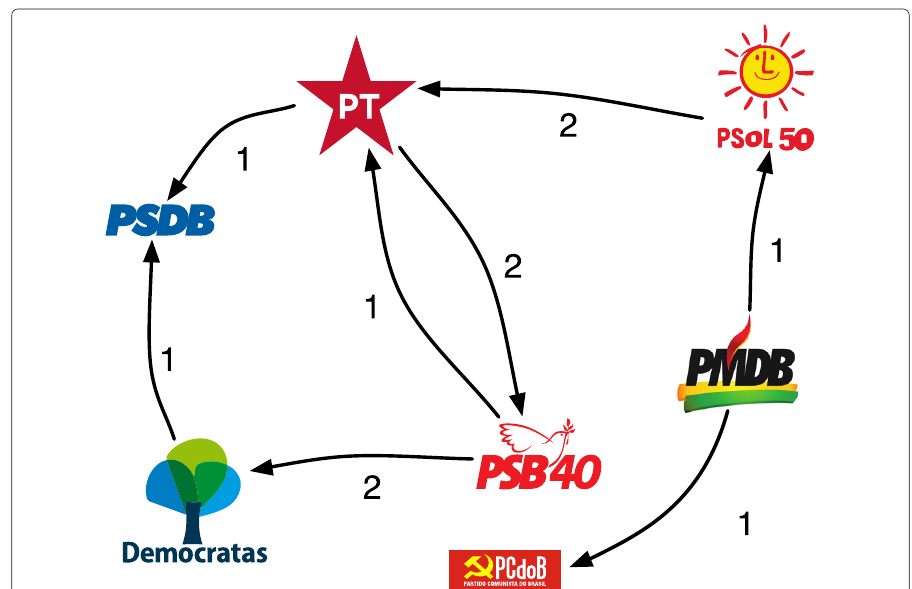
Fig. 1 The movement of candidates between parties yields a network of parties. Each candidate movement generates a connection between two parties. The result is a network where nodes represent parties and edges represent the connections among them. The weight w y ij of an edge represents the total number of candidates switching from i to j in year y . See Additional file 1: Table S2 for details about the political